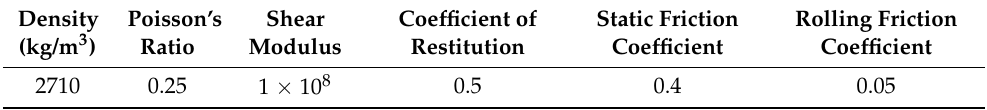
Table 5. Particle physical parameters.